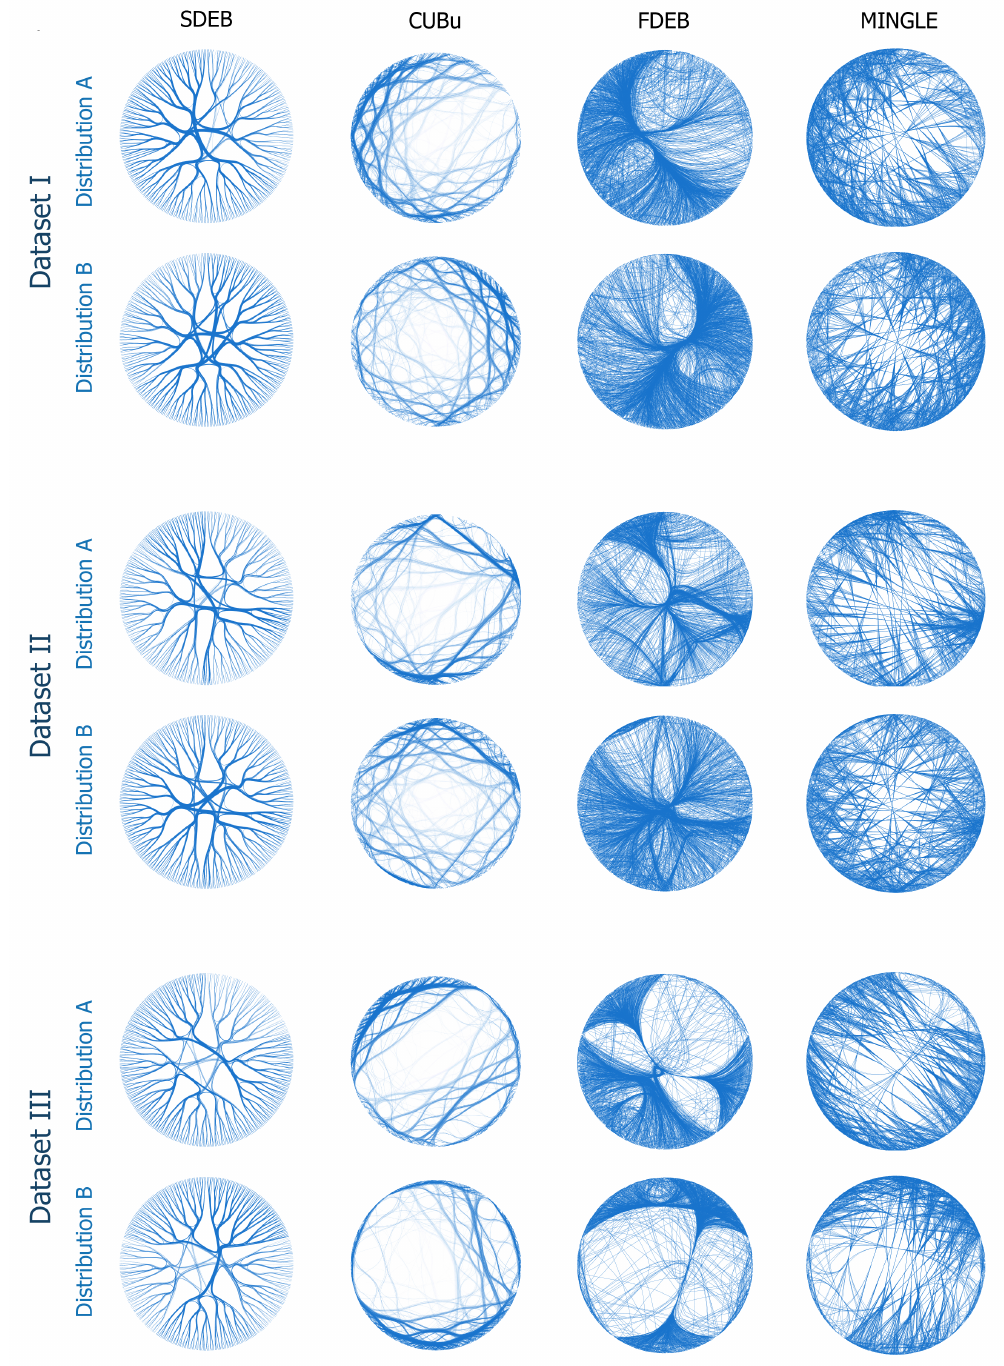
Figure 6. A comparison among the results attained by the SDEB, CUBu, FDEB, and MINGLE using the radial layout. FDEB fails to present well-defined bundles. MINGLE creates bundles with a few edges, but the layout is heavily cluttered in the visualization border. CUBu presents a similar problem, leaving the center empty and the border crowded with too much information. SDEB does not agglomerate the edges around the border while also makes better use of the visual space. Most crossings in the SDEB layout happen in different directions, reducing ambiguities resulted from edges